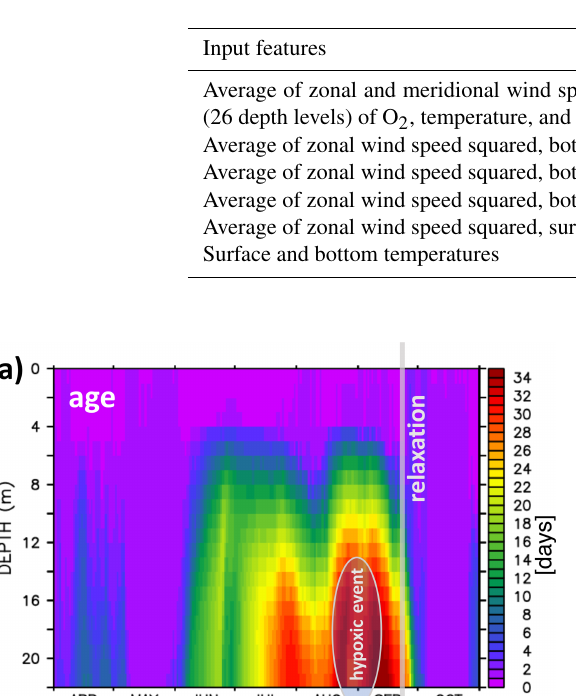
Table 3. Capacity estimation of input features. This table relates the fidelity of biweekly walk-forward ANN forecasts of bottom oxygen concentrations at the monitoring station Buoy 2a with data from station Boknis Eck fed to the ANN. The average of wind speed squared refers to respective biweekly forecasts of zonal winds. The error is the RMS deviation between the (computationally cheap) ANN projection and simulated (computationally expensive; full-fledged coupled biogeochemical ocean circulation model) bottom oxygen concentrations at Buoy 2a relative to the respective RMS of the persistence model (which naively assumes that Boknis Eck bottom oxygen concentrations will persist for 14d at Buoy 2a .